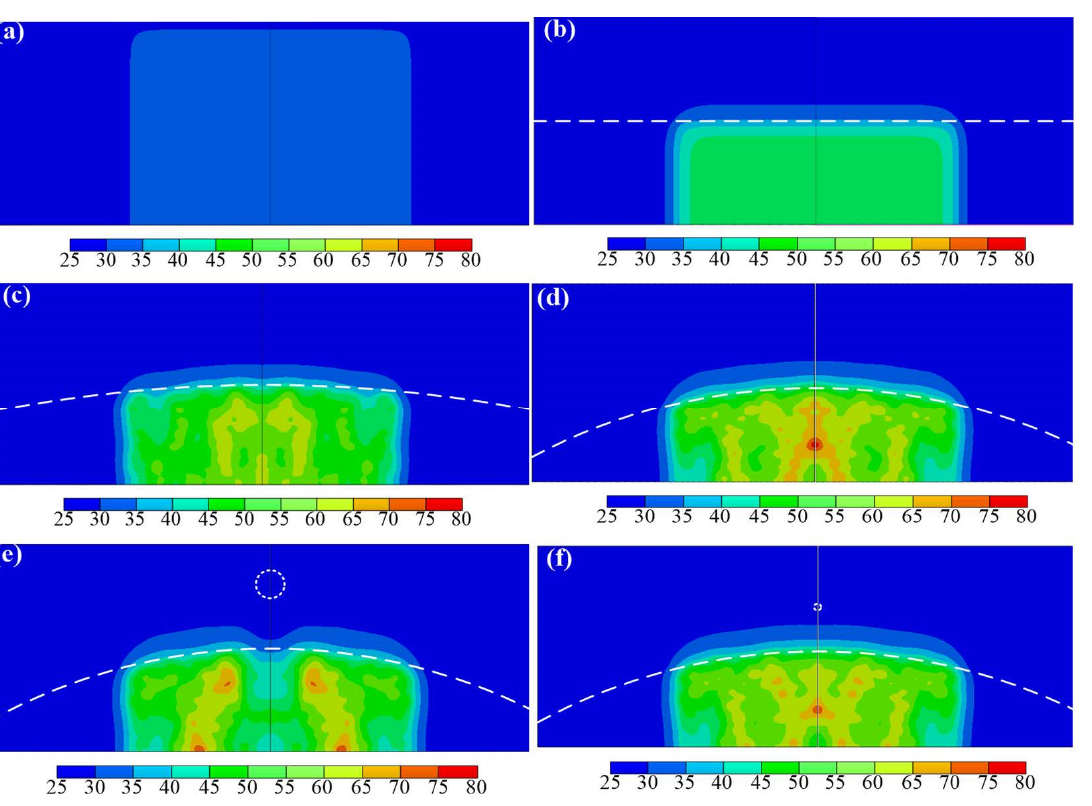
Figure 3. Normalized pressure distributions in the composite systems (Cases ( a – j )).